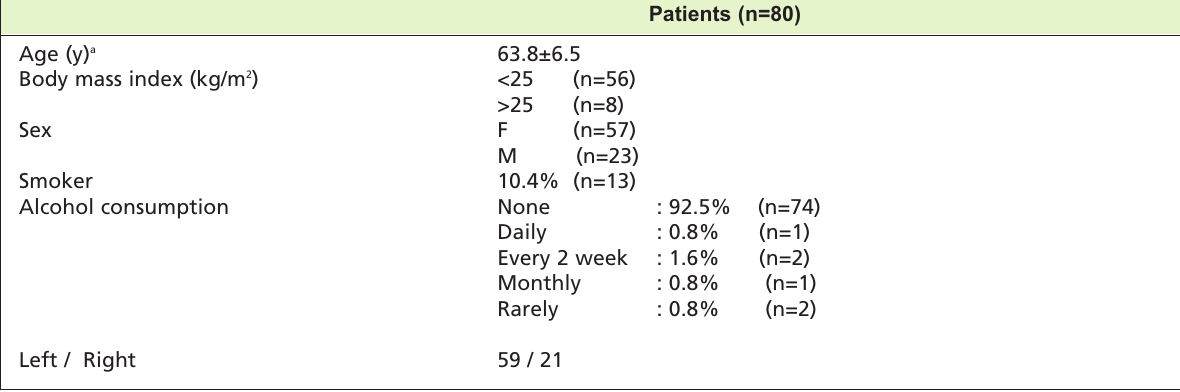
Demographic and clinical data of participants Table I: